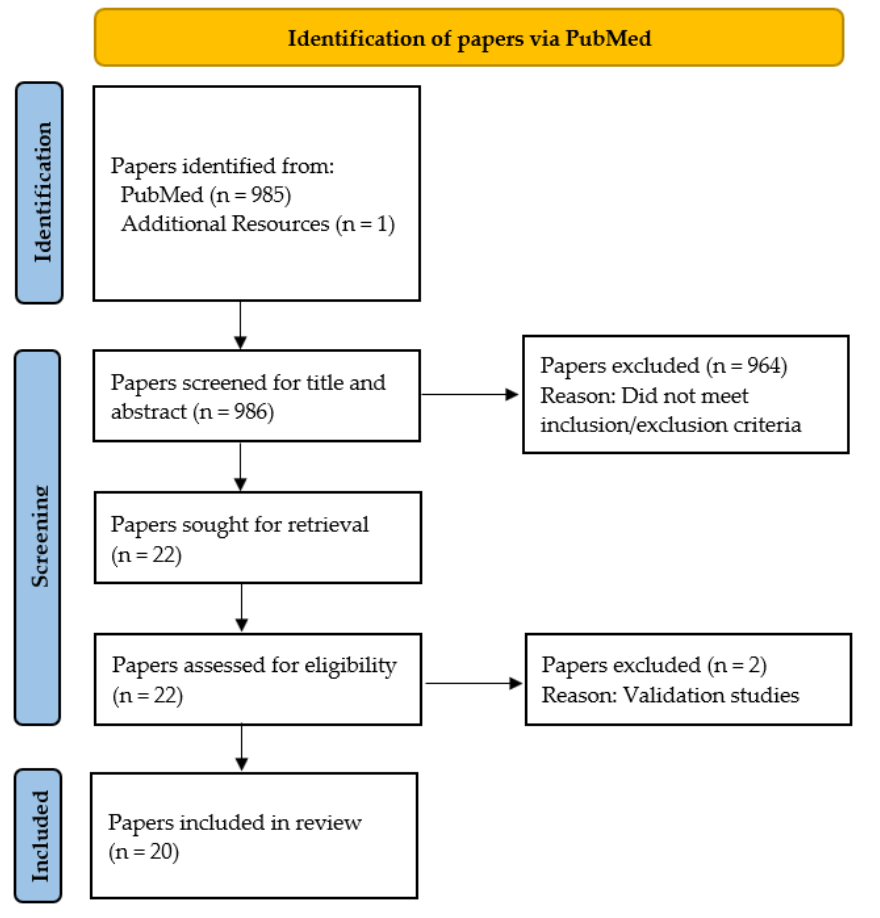
Figure 1. Flow chart for selecting papers.